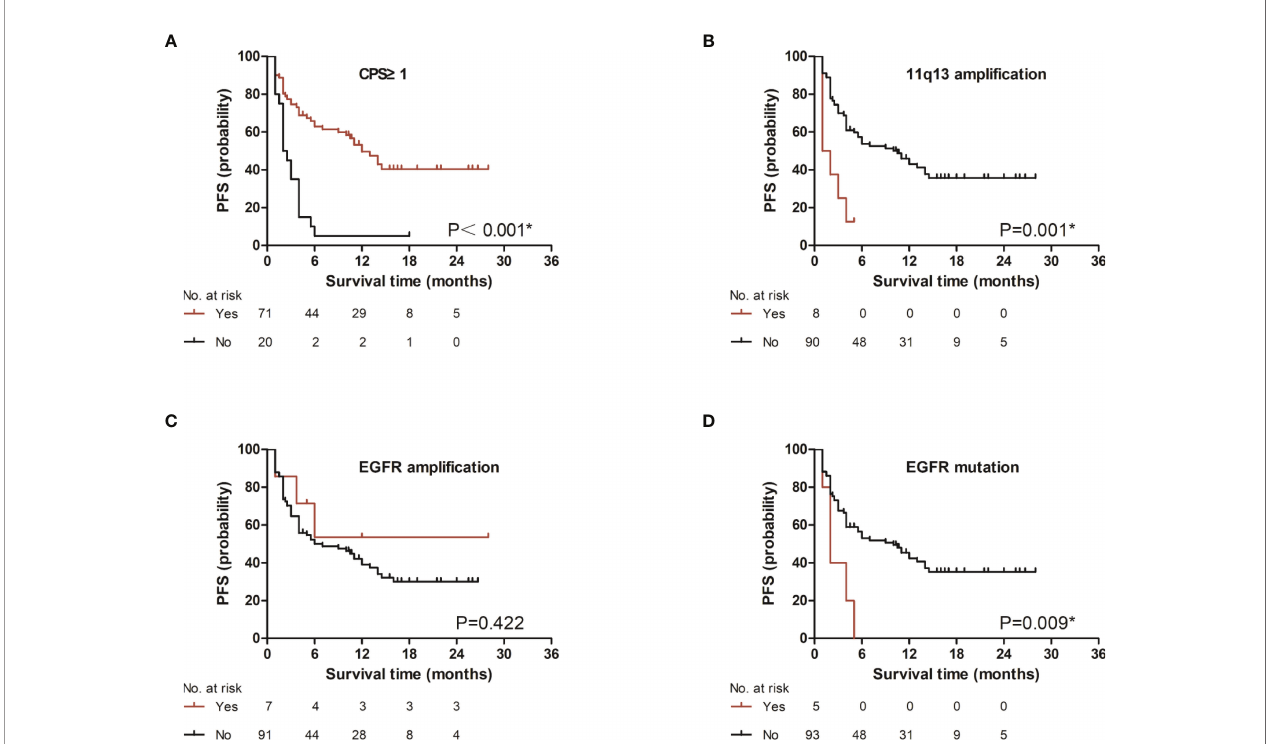
FIGURE 1 | Association of several factors with progression-free survival in patients treated with PD-1 inhibitor. Association of (A) CPS level. (CPS, combined positive score), (B) 11q13 ampli fi cation status. (11q13: CCND1_FGF3_FGF4_FGF19 or any one of them), (C) EGFR ampli fi cation status, or (D) EGFR mutation status, with progression-free survival.